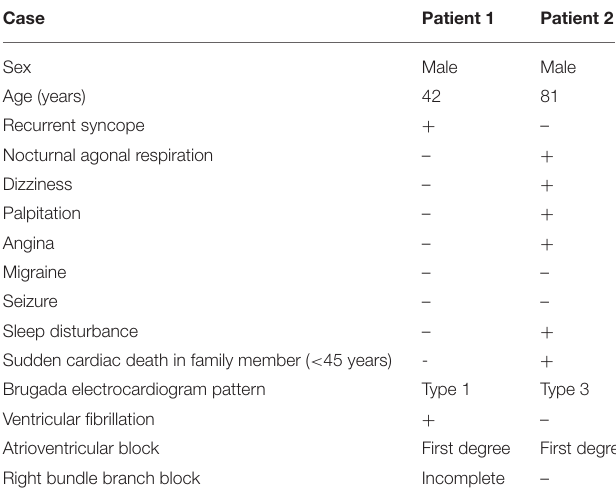
TABLE 1 | Clinical characteristics of two